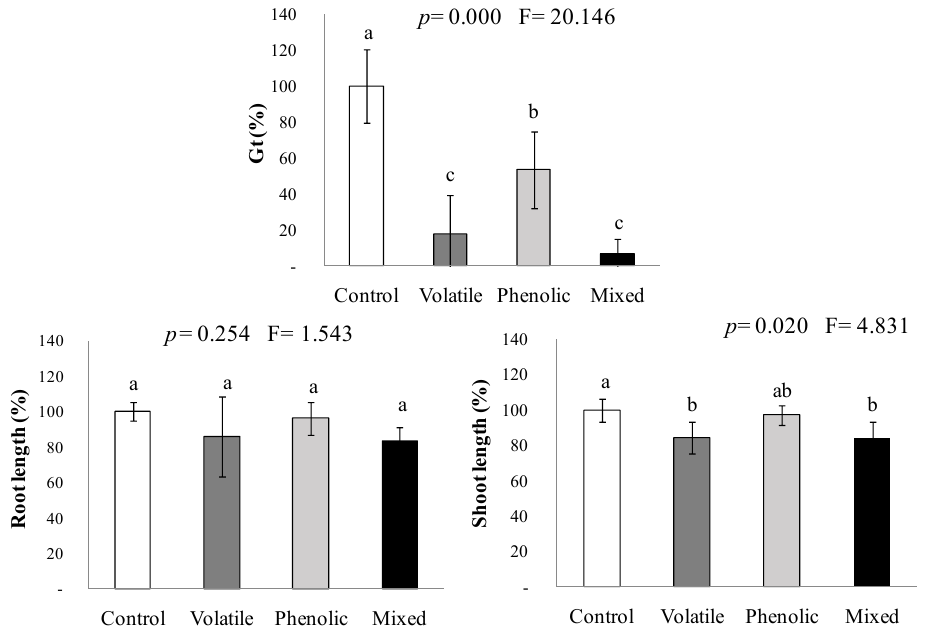
Figure 3. Effects of mimicked volatile and mimicked phenolic fractions of Cytisus scoparius , applied separately or concomitantly (mixed) in 1 L hermetic chambers, on the total percentage of germinated seeds (Gt) and early growth of Amaranthus retroflexus . Mean values of four replicates are represented in percentage relative to control. Error bars represent standard deviation (S.D.). p - and F-values of the effects of treatments from by one-way ANOVA or Kruskal-Wallis H tests are shown. Mean values labeled with distinct letters denote statistically significant differences among treatments (post hoc LSD or Tamhane’s T 2 test).